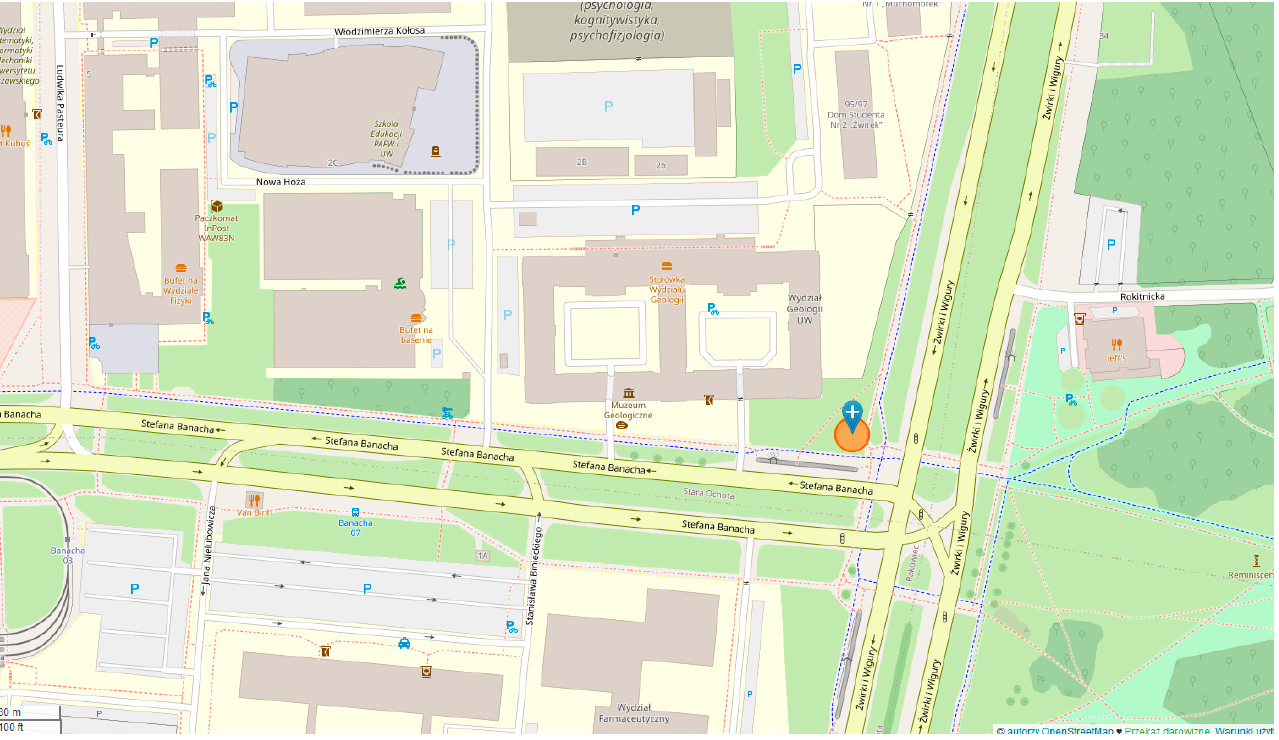
Figure 3. Location of the measuring station at Stefana Banacha street (own study, based on www.openstreetmap.org), accessed on 19.01.2022.